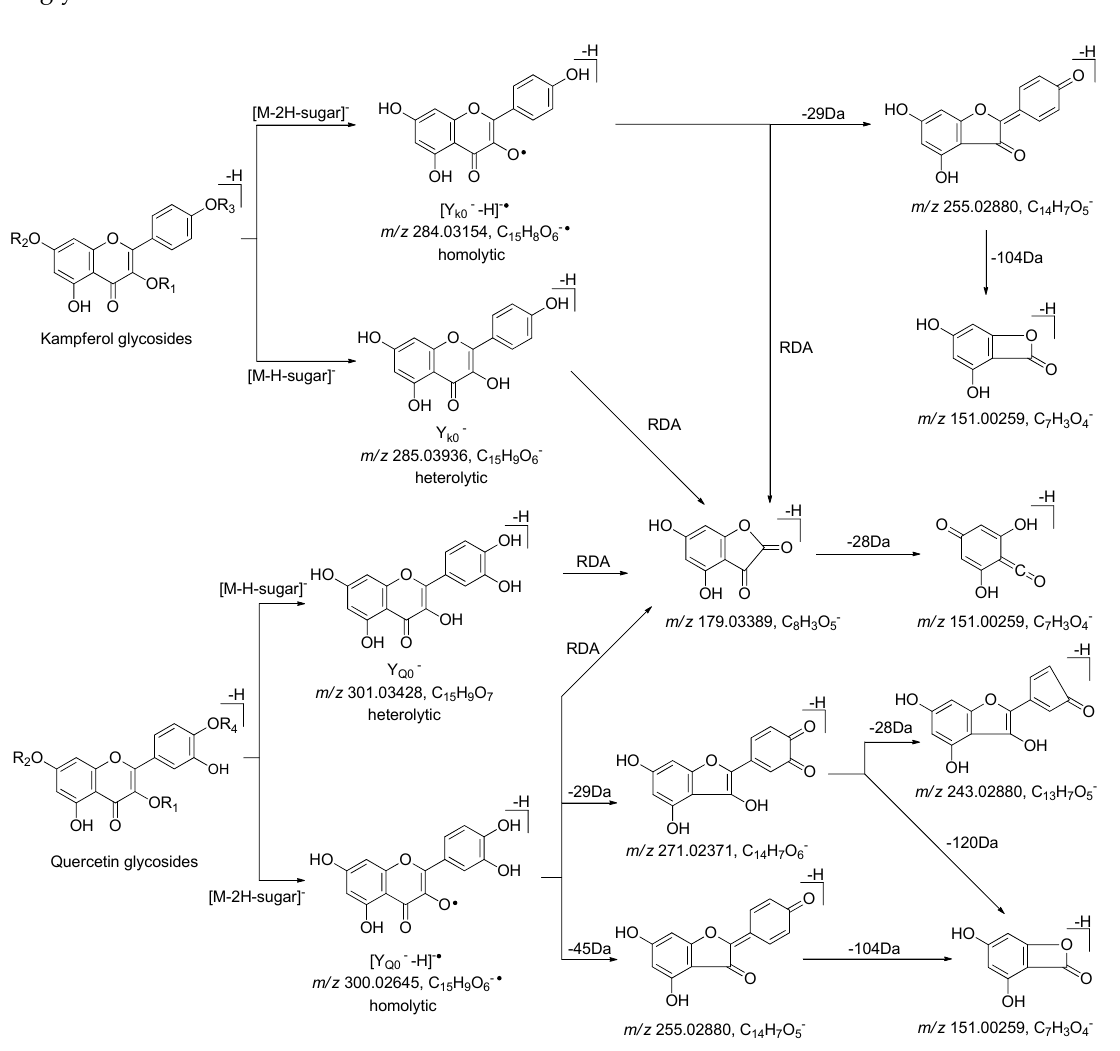
Figure 9. The proposed fragmentation pathways of kaempferol and quercetin glycosides.